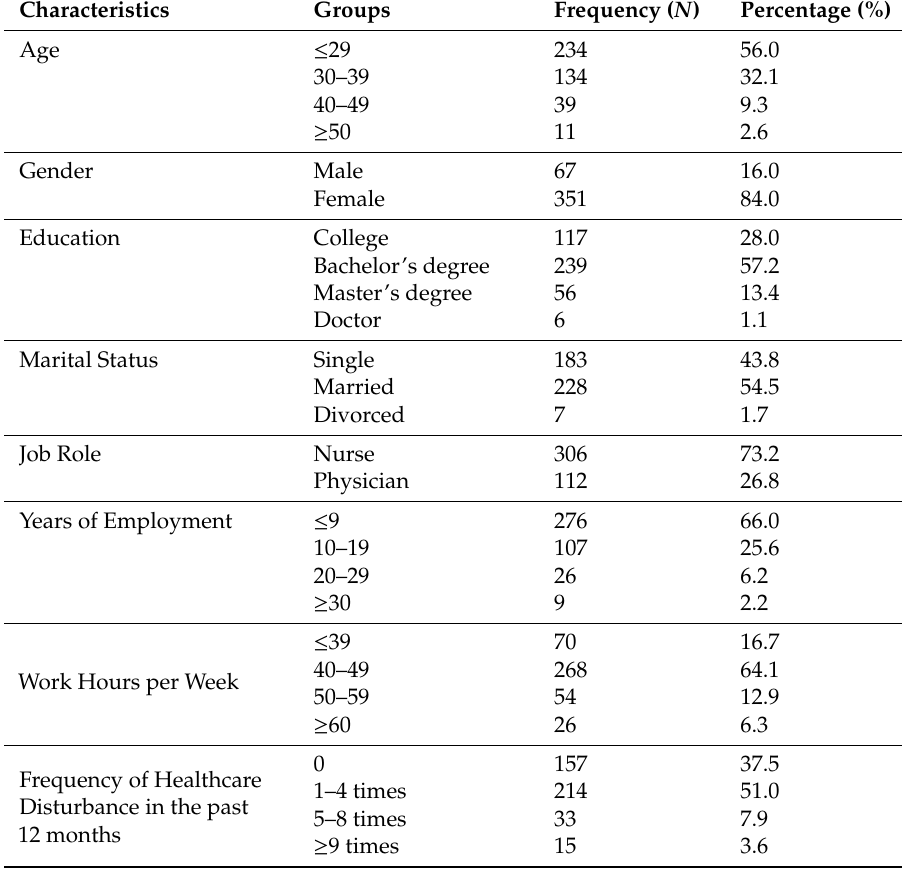
Table 1. Sociodemographic characteristics of the participants ( N =